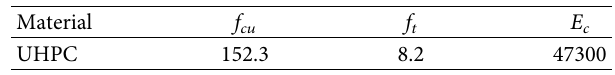
Table 2: Material properties of UHPC (units: MPa).